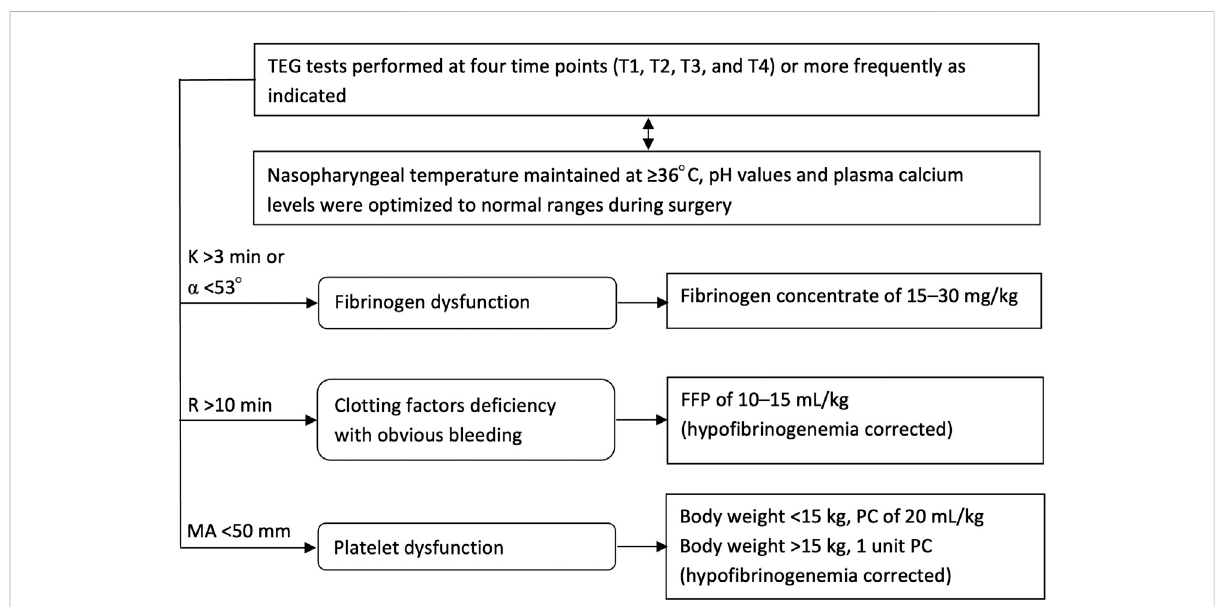
FIGURE 1 Flow chart for the TEG-guided hemostatic algorithm. TEG, thromboelastography; T1, prior to incision; T2, cutting of the dura mater; T3, suturingoftheduramater;T4,afterscalpclosure;K,coagulationtime; α angle,angleofdivergence;R,reactiontimetoclotformation;MA,maximum amplitude of clot strength; FFP, fresh frozen plasma; PC, platelet apheresis